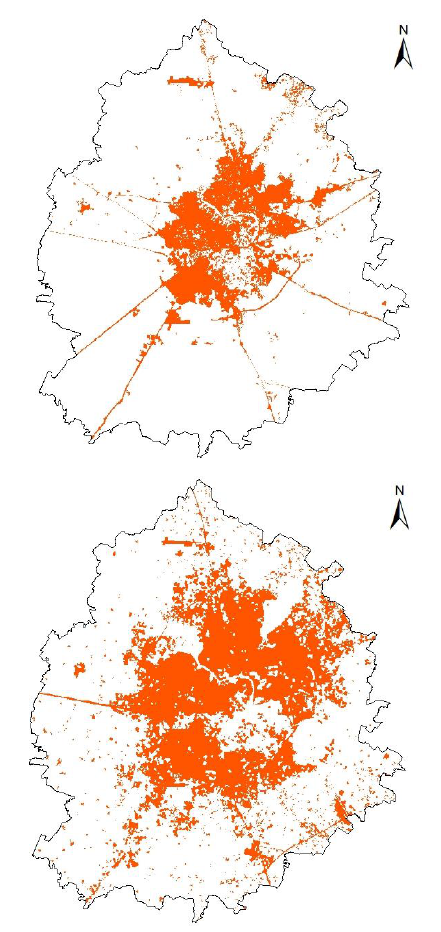
Figure 6: Binary Maps of Built-up (2003,2013) Change Detection: The transitions from one class to another were obtained from the Matrix Union tool in Erdas Imagine 2014. Both the LULC’s were the inputs and the output were shown in the attribute table as each class being changed into class number 1,2,3, etc. and then it was copied and analyzed in the Microsoft Excel to find out the changes. The major change occurred due to transition from sparse vegetation, agricultural land, fallow/open land into Built up left as fallow land. Also that it will be converted into open land and made usable for built-up. In Error! Reference source not found. by 4.22 sq. km., Table 6: Percentage distribution and rise in LU/LC for each 6.50 sq.km. and 9.88 sq.km. respectively. The transition of Class(Lucknow) sparse vegetation into agricultural land, quantified as 4.28 sq.km. The transition of agricultural land into sparse vegetation was 7.10 sq.km, fairly justified as the agricultural land is seasonally used and 5.3, all the transitions from other classes converted into built-up are shown. The maximum conversion of land use into built up was of sparse vegetation of the value 3.08 sq. km ( Figure 7.0 ) i.e.